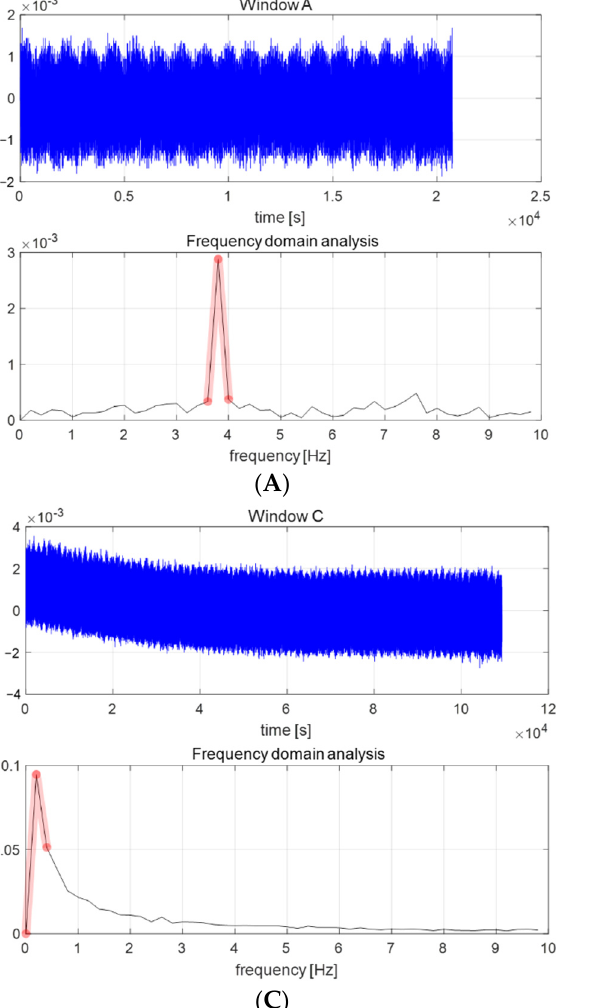
Figure 4. Original acoustic signal and frequency domain characteristics of window A–D. ( A ), Filtered acoustic signal before the ESC; ( B ), Filtered acoustic signal during the ESC; ( C ), Filtered acoustic signal near-end after the ESC; ( D ), Filtered acoustic signal far-end after the ESC.